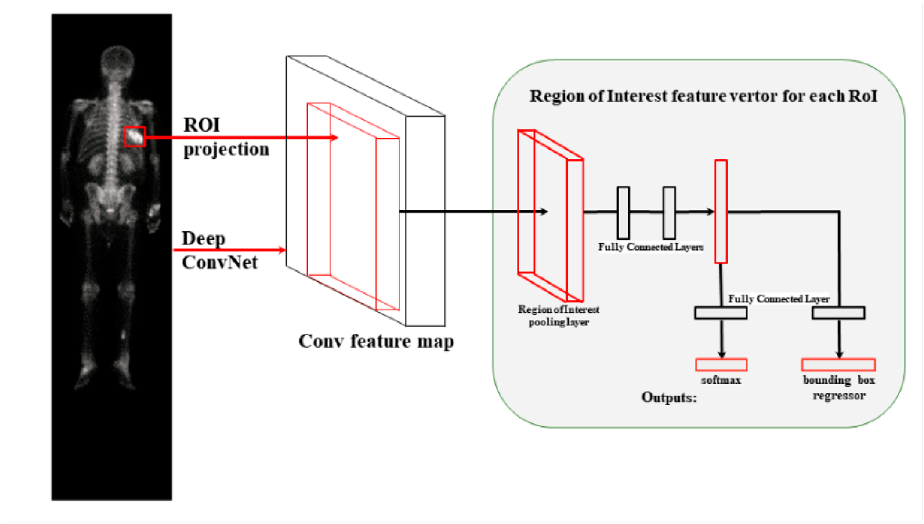
Figure 3. Faster R-CNN